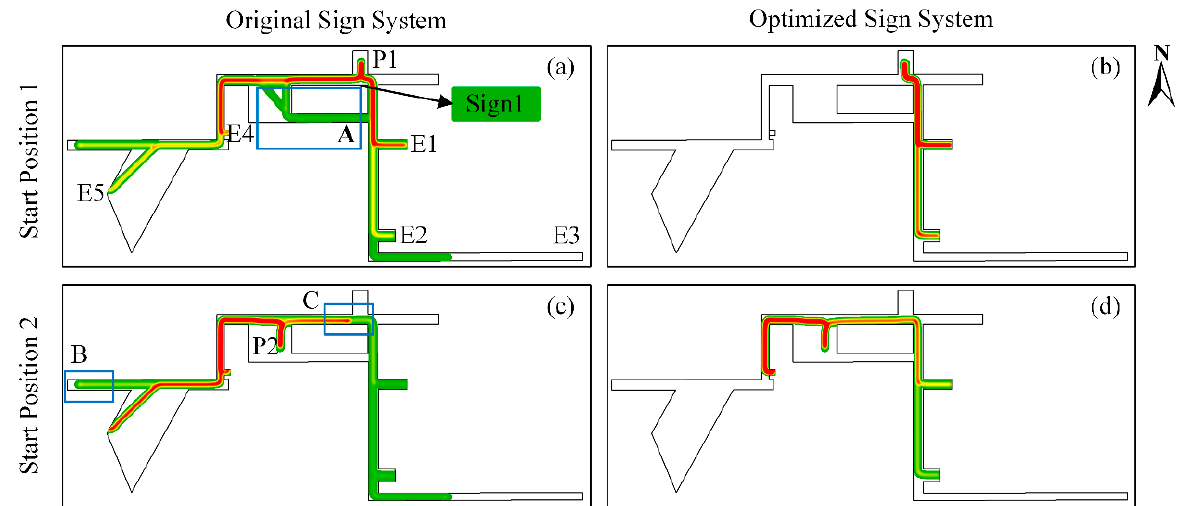
Figure 15. Comparison of trajectory hotspot charts before and after optimization of the model simulation. ( a ) Simulation result with the original sign system, and participants starting from P1; ( b ) Simulation result with the optimized sign system, and participants starting from P1; ( c ) Simulation result with the original sign system, and participants starting from P2; ( d ) Simulation result with the optimized sign system, and participants starting from P2. Table 1. Pearson correlation coefficient test of the trajectory spatial distribution between the VR experiments and the model